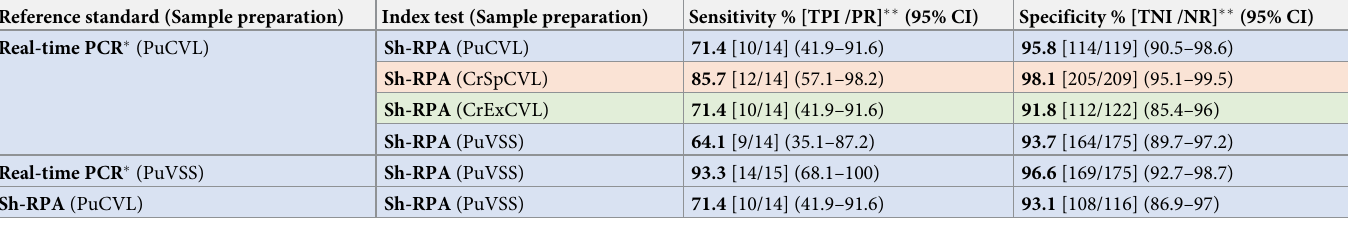
Table 1. Sh-RPA performance and sample preparation comparisons using DNA isolated from CVL and VSS samples by QIAamp Mini Kit (coloured blue), SpeedX- tract (coloured orange) and Extracta (coloured green), extraction